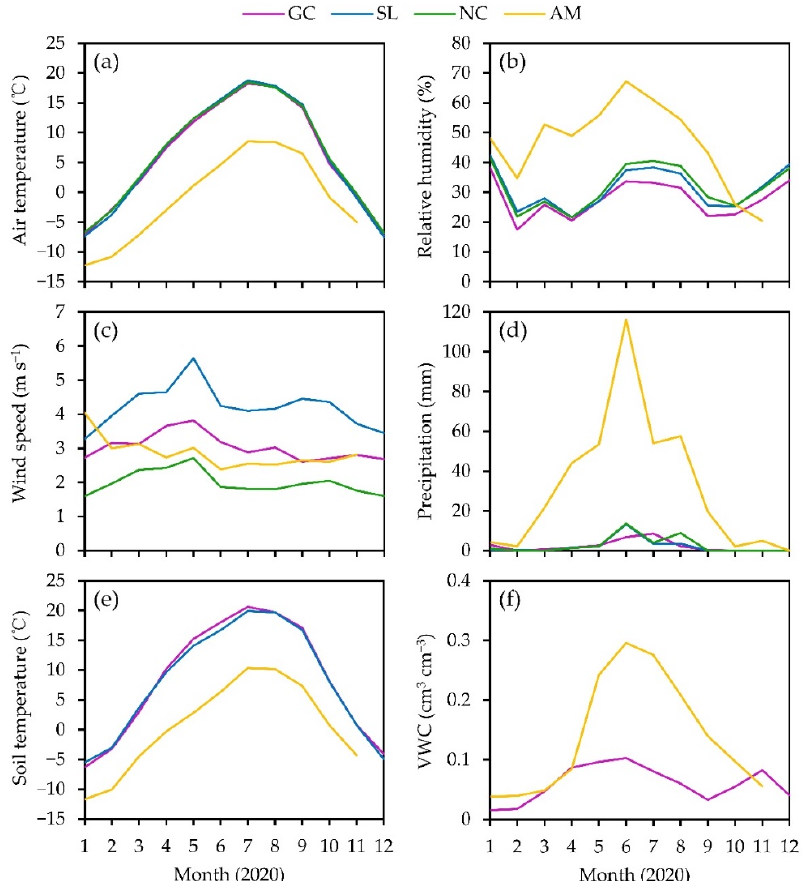
Figure 2. Monthly variation of different environmental factors at four observation stations in the Qaidam Basin in 2020. Monthly averages of: ( a ) air temperature; ( b ) relative humidity; ( c ) wind speed; ( e ) soil temperature; ( f ) soil volume water content (VWC); and ( d ) cumulative precipitation. GC is Lyceum barbarum cropland in Golmud, SL is shrubland of Tamarix chinensis and wild Lycium barbarum , NC is Lyceum barbarum cropland in Nuomuhong, and AM is alpine meadow.